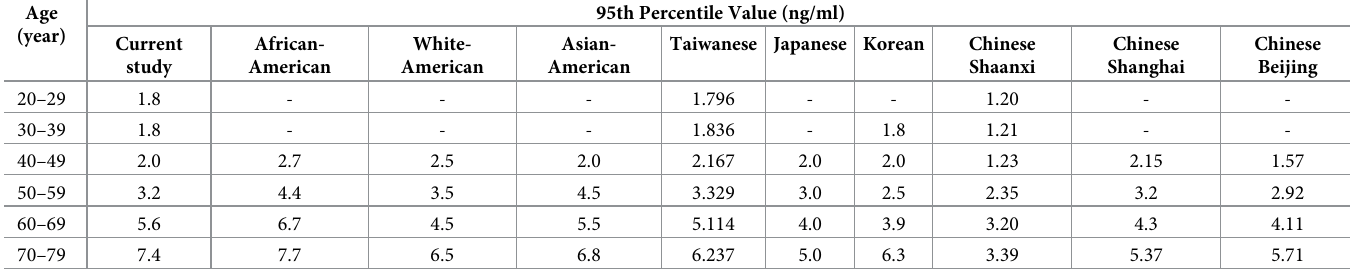
Table 3. Comparison of serum PSA levels among African-Americans [21], Caucasian Americans [7], Asian-Americans [21], Taiwanese [15], Japanese [8], Koreans [11], and Chinese [12–14]. Age